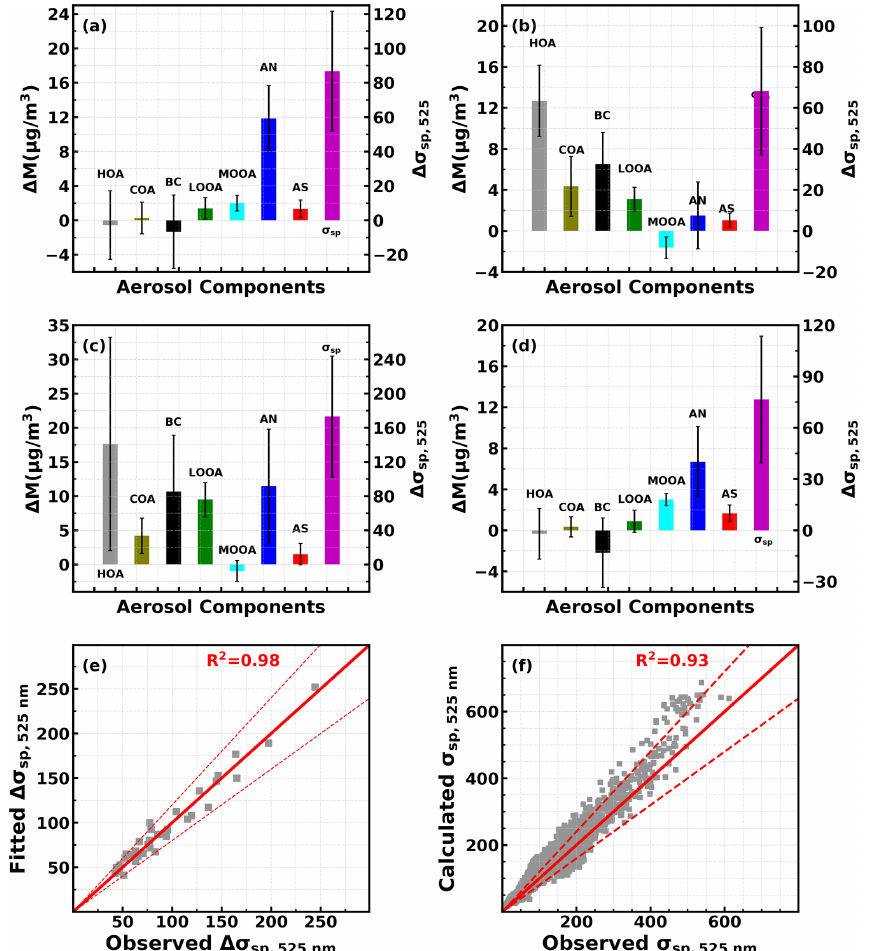
Figure 2. Average changes of aerosol components and σ sp , 525 (right axis) for identified increase cases of (a) nitrate,; (b) HOA, (c) LOOA and (d) MOOA. Black error bars represent standard deviations. (e) Comparisons between observed σ sp , 525 changes for identified cases and multiple linear fitted values. (f) The comparison between observed σ sp , 525 and calculated σ sp , 525 using retrieved MSEs of aerosol components. Dashed red lines represent 20% deviation